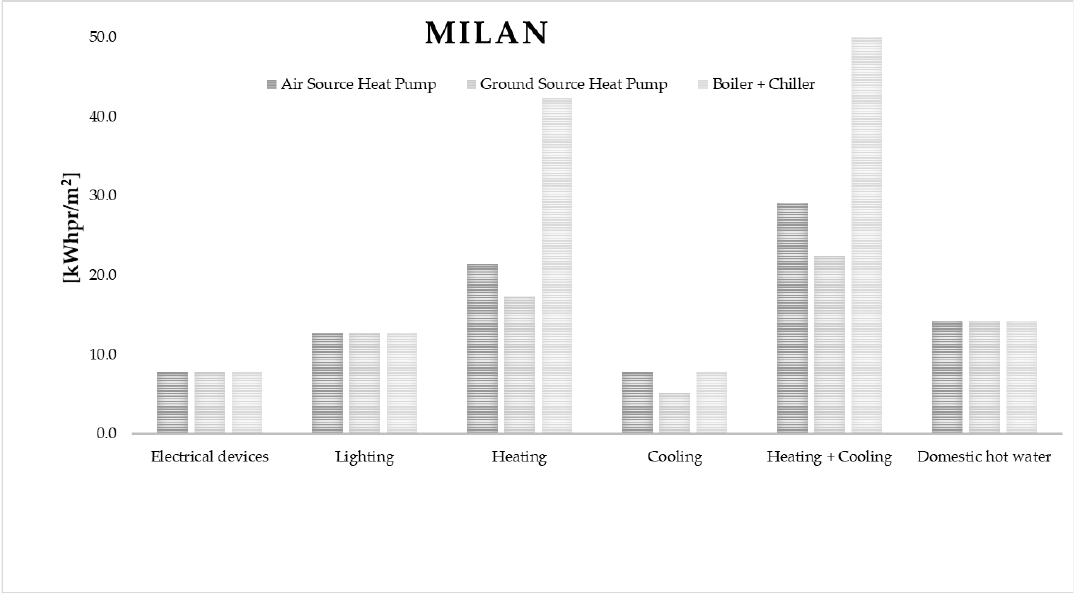
Figure 5. Primary energy demand (kWh/m 2 y) for the three different proposed systems in the case of Milan.